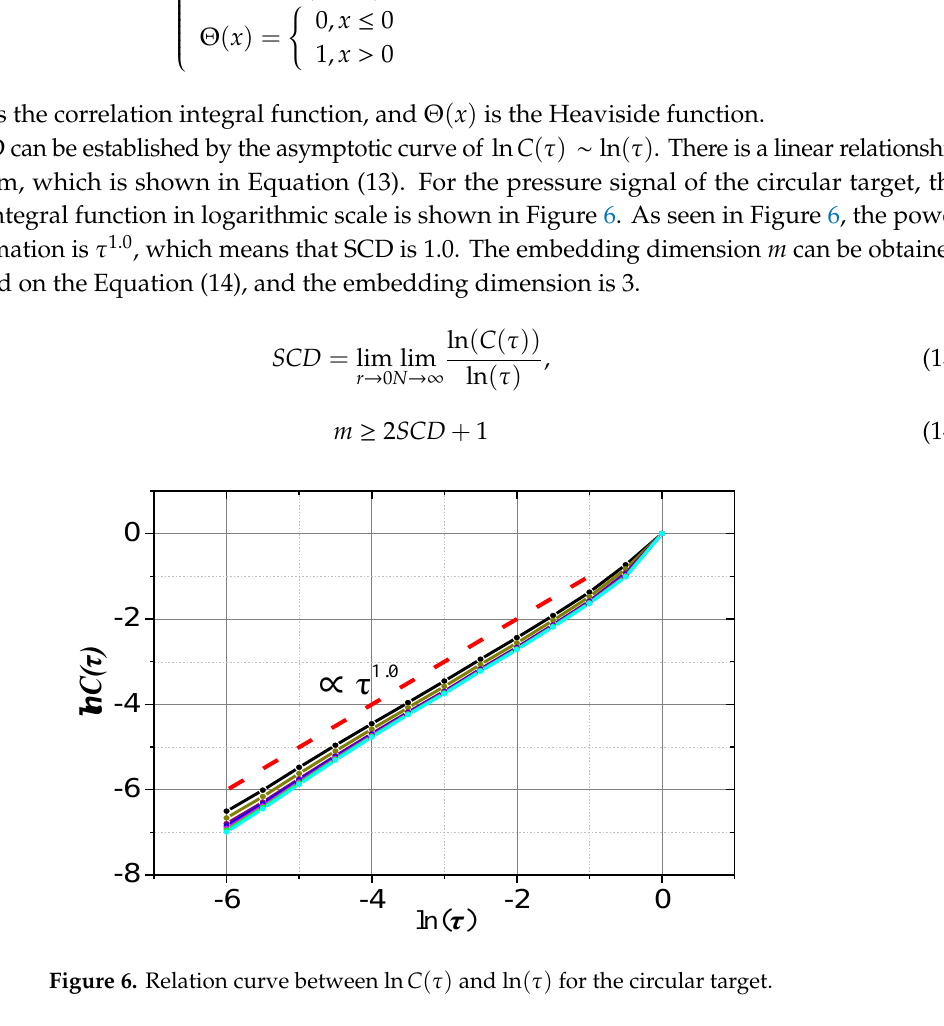
Figure 7. Relation curve between )(ln  C and )ln(  for the triangular target.